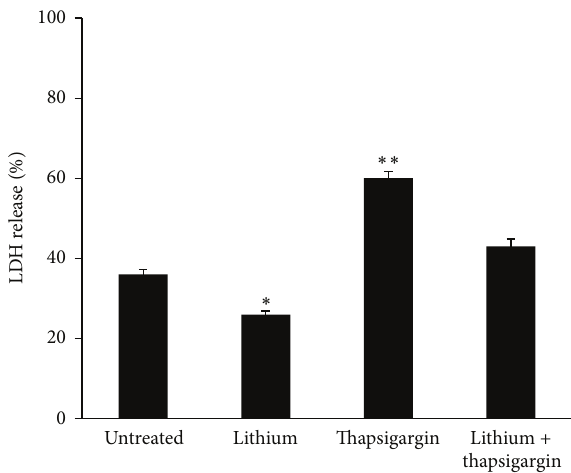
Figure 2: LDH release in the culture medium of PC12 cells treated for 24 hours with 100nM thapsigargin alone or in combination with 0.5 mM lithium. Lithium treatment significantly reduces the thapsigargin-induced LDH release; a low but significant decrease in LDH release is observed in cultures treated with lithium alone with respect to the untreated control. Averages ± SEM of three independent experiments. ANOVA with Bonferroni’s-corrected 𝑡 - test. ∗ 𝑃 < 0.01 , ∗∗ 𝑃 < 0.001 versus untreated